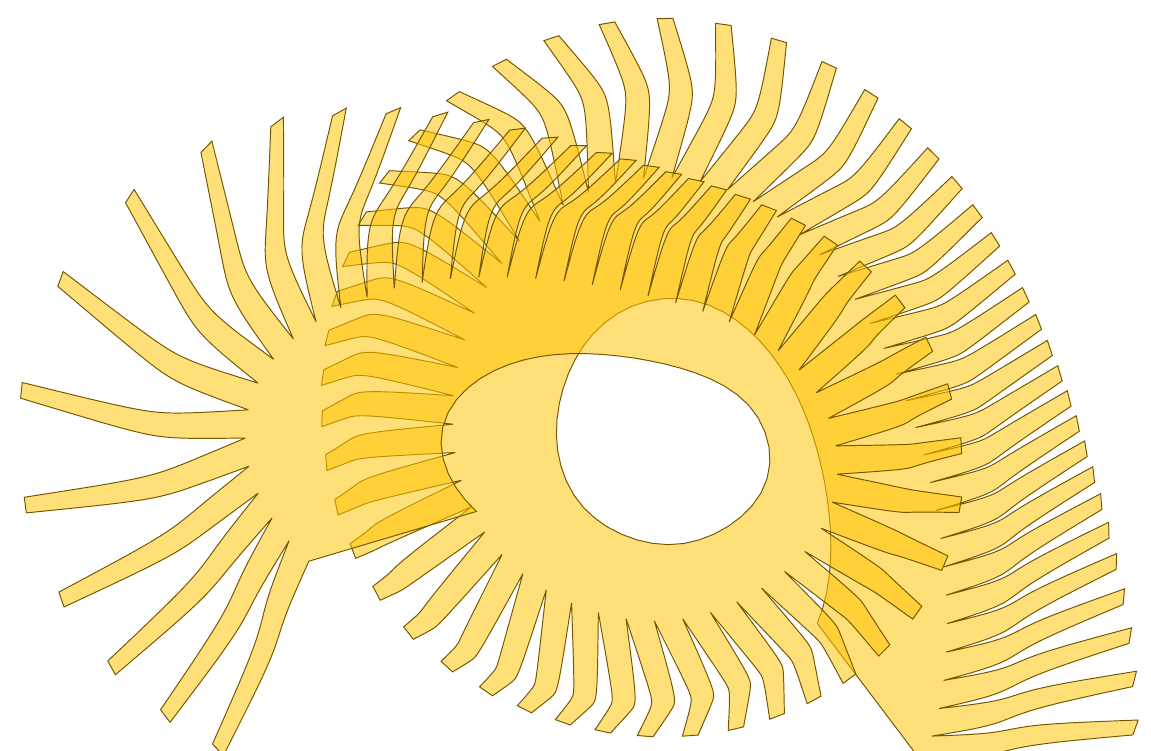
Figure 42. An unrolled method four surface from Figure